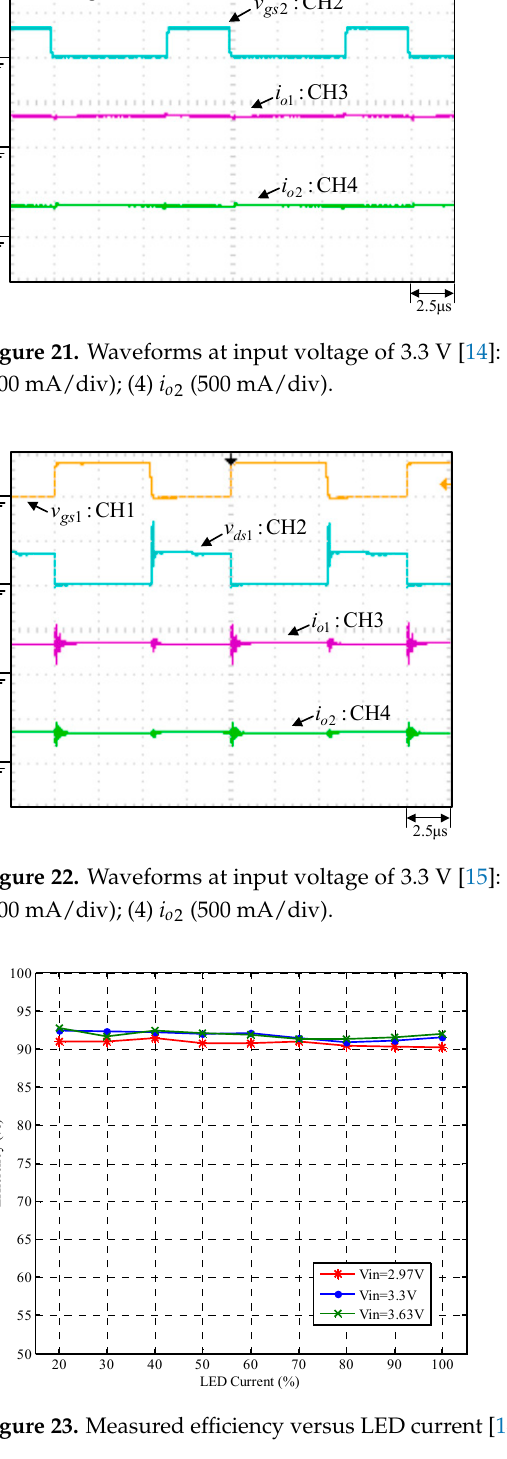
Figure 24. Measured efficiency versus LED current [15]. 6. Conclusions An isolated LED driver based on the LLC resonant converter is presented herein. In the proposed LED driver, the current-sharing capacitor is used to balance the LED cur- rents. Therefore, the active current sharing circuits are not required. From the experi- mental results, it can be seen that the currents in the two LED strings are identical without considering the difference in equivalent forward voltage between the two LED strings.